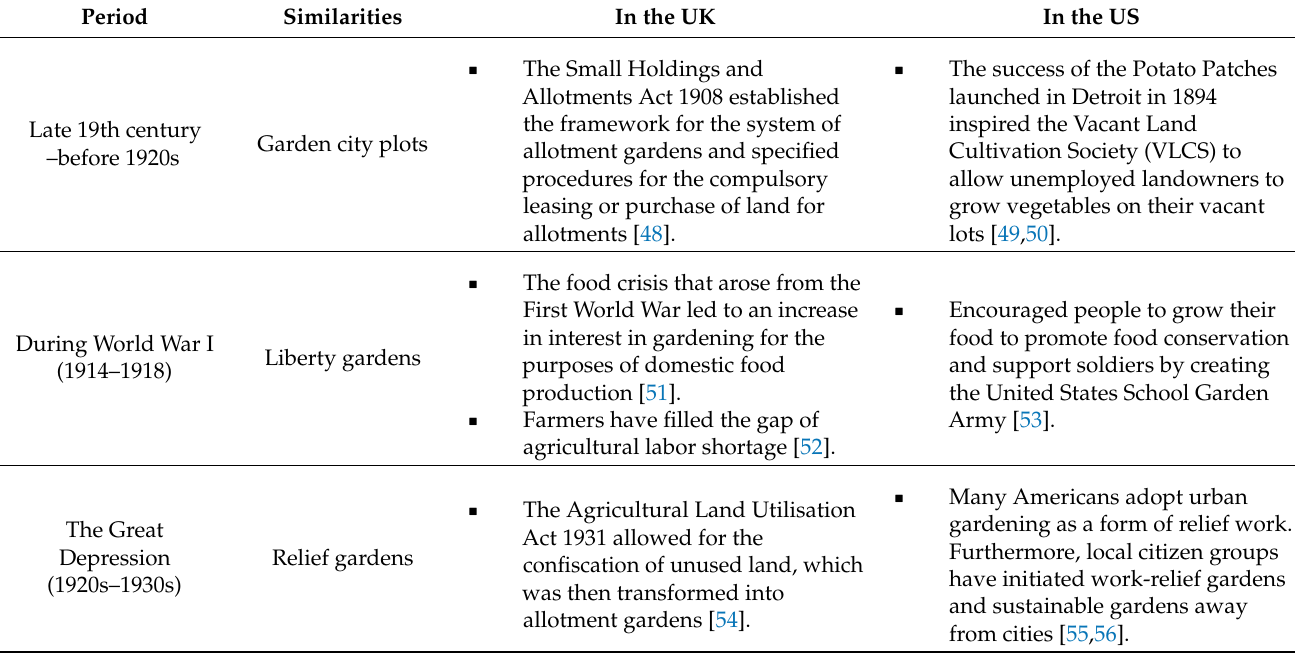
Table 1. Similarities between the garden movements in the UK and the